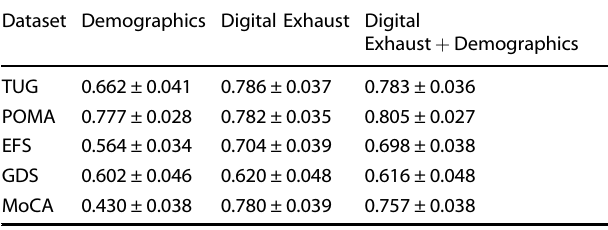
Table 1. Performance Evaluation based on ROC AUC. Dataset Demographics Digital Exhaust Digital Exhaust + Demographics